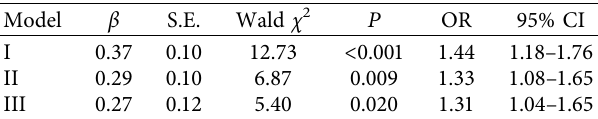
Table 4: Association between the TyG index stratified by the most effective threshold value and LAA